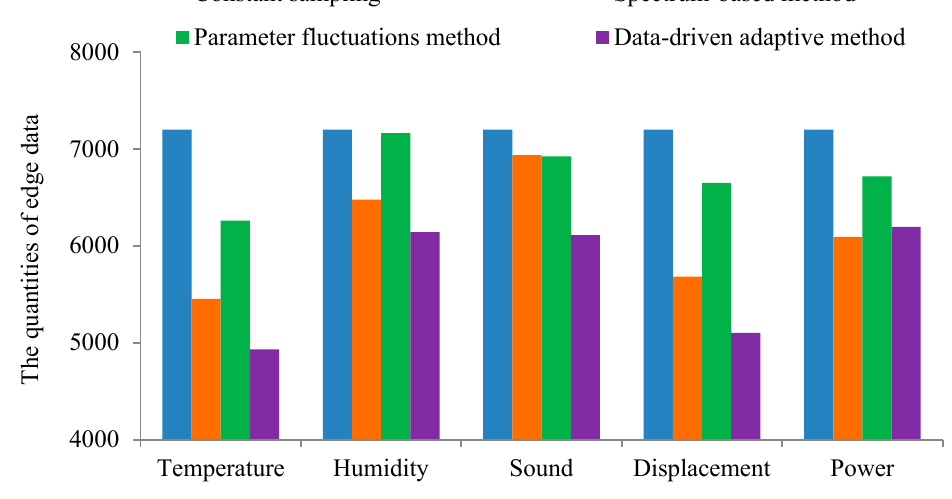
Figure 10. The quantities of edge data.